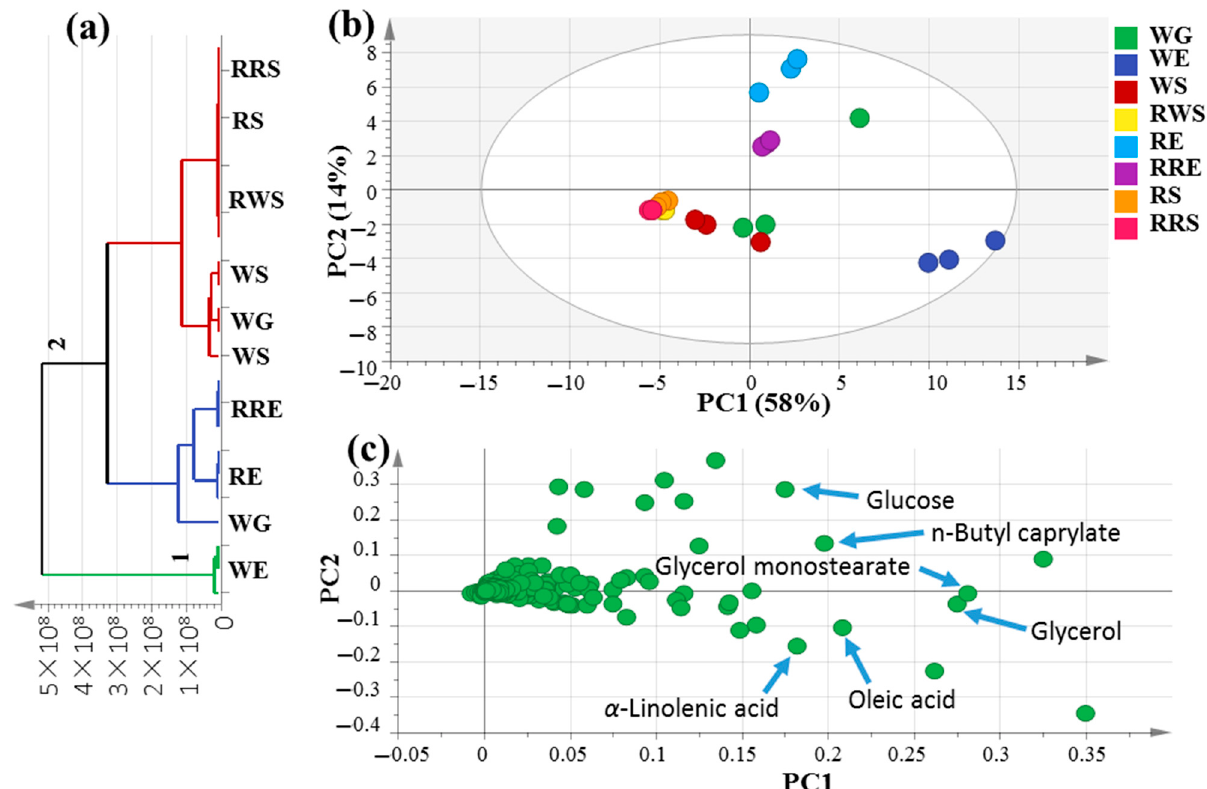
Figure 2. Unsupervised multivariate data analyses of the studied P. mahaleb seeds derived from modeling silylated primary metabolites analyzed via GC–MS ( n = 3). ( a ) HCA plot. ( b ) PCA score plot of PC1 vs. PC2 scores. ( c ) The respective loading plot for PC1 and PC2, providing mass peaks and their assignments. The metabolome clusters are placed in two-dimensional space at the distinct locations defined by two vectors of principal component PC1 = 58% and PC2 = 14%.